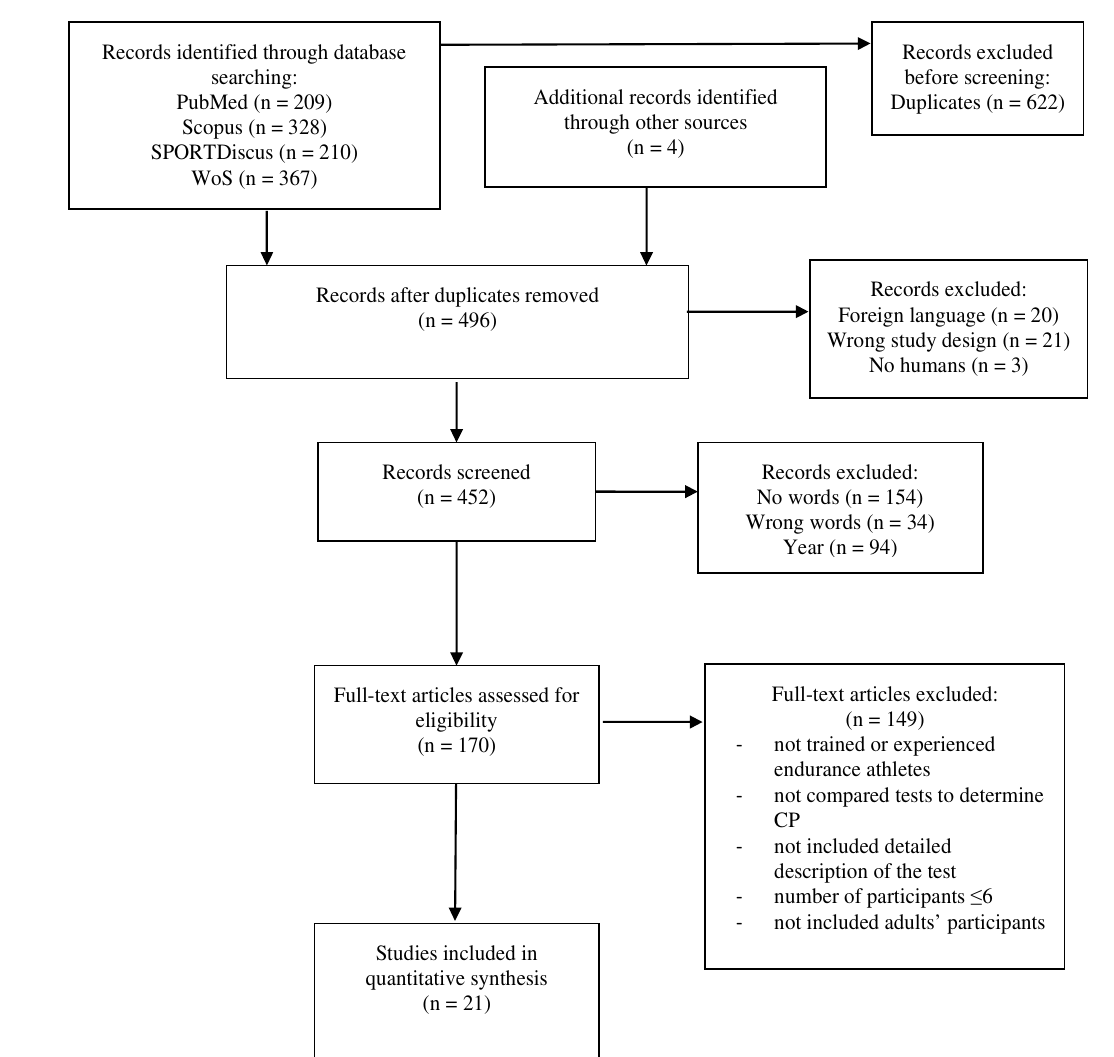
Figure 2. PRISMA flow diagram of the search strategy.